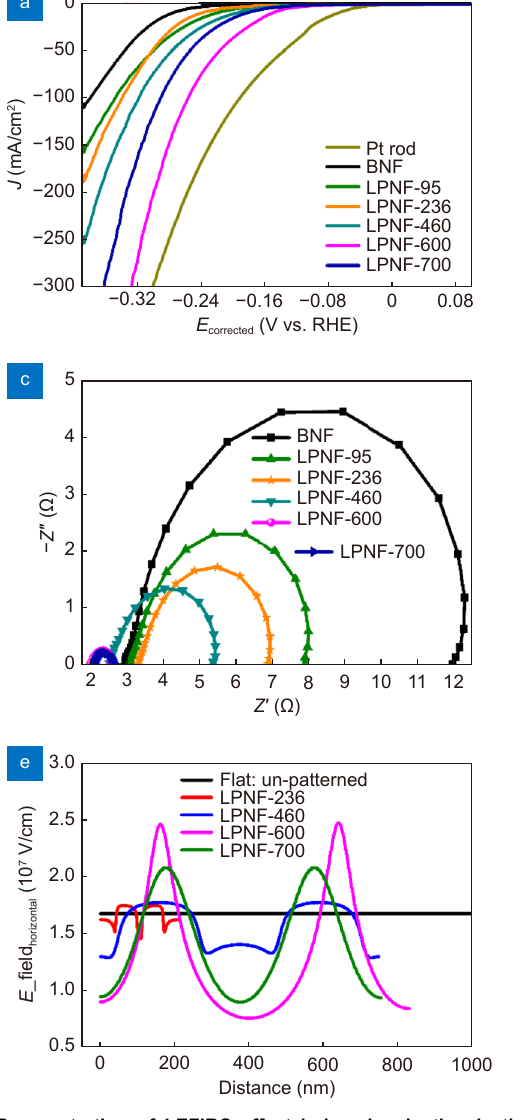
Fig. 4 | Demonstration of LEFIRC effect induced reduction in the overpotential for electrochemical hydrogen generation when the LIPSS patterned electrode is directly used as electrocatalyst . HER performance of BNF and different LPNF electrodes with Pt/C electrode as a reference in 1.0 M KOH solution at room temperature: ( a ) the LSV curves and corresponding, ( b ) Tafel slopes, and ( c ) Nyquist plots. ( d ) The LSV curves before (solid black) and after (dotted red) 2000 CV cycles. ( e ) The FEM simulation for the distribution of electric field intensity along the horizontal line for the different LIPSS patterns without considering the effects of nanoparticles. ( f ) Comparison of electric field localization at the ridges of LPNF- 600 and LPNF-700 electrodes with the addition of NPs of average sizes 15 nm, and 40 nm respectively. Inset (correspond- ing 2D mapping of electric field